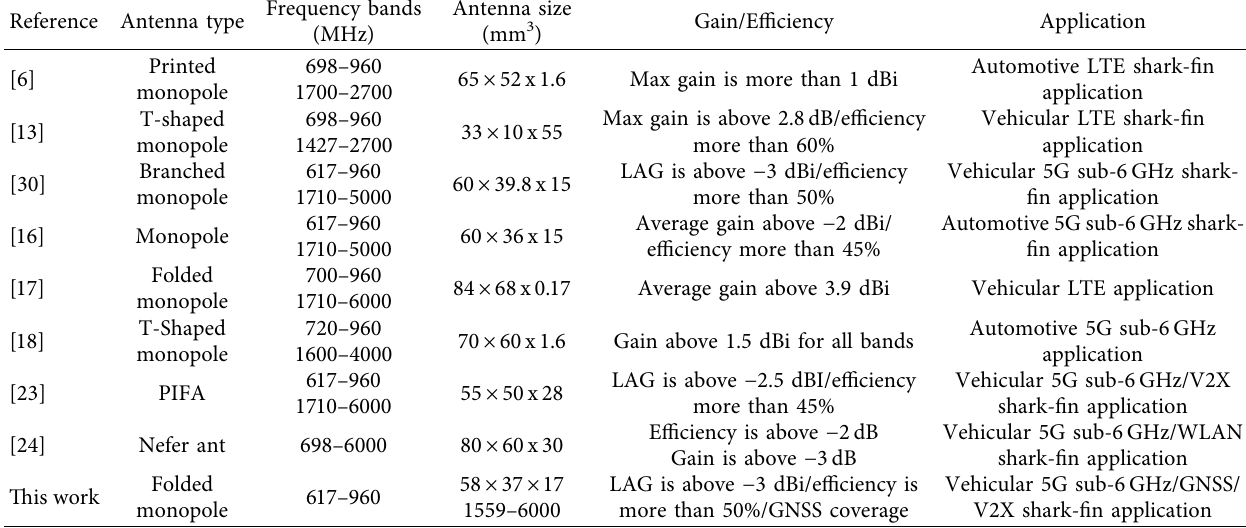
Table 3: Comparison between the proposed monopole antenna and other antennas from the